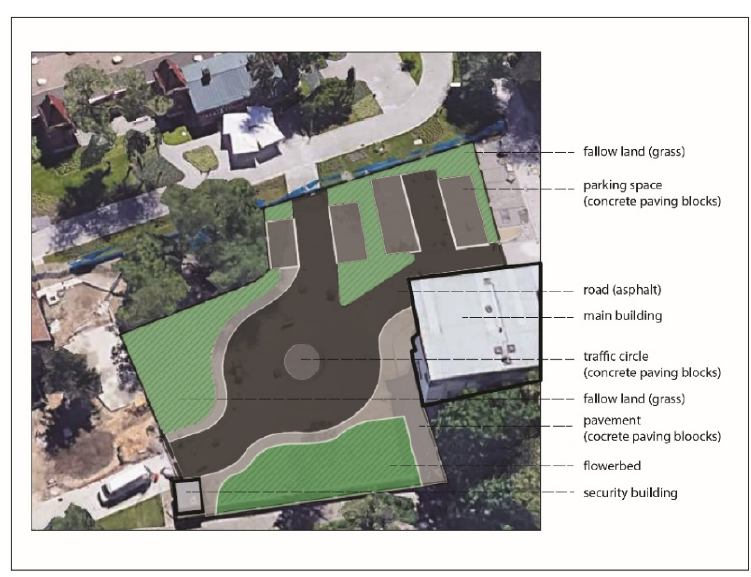
Figure 1. The current state of the area near the Customer Support Centre.